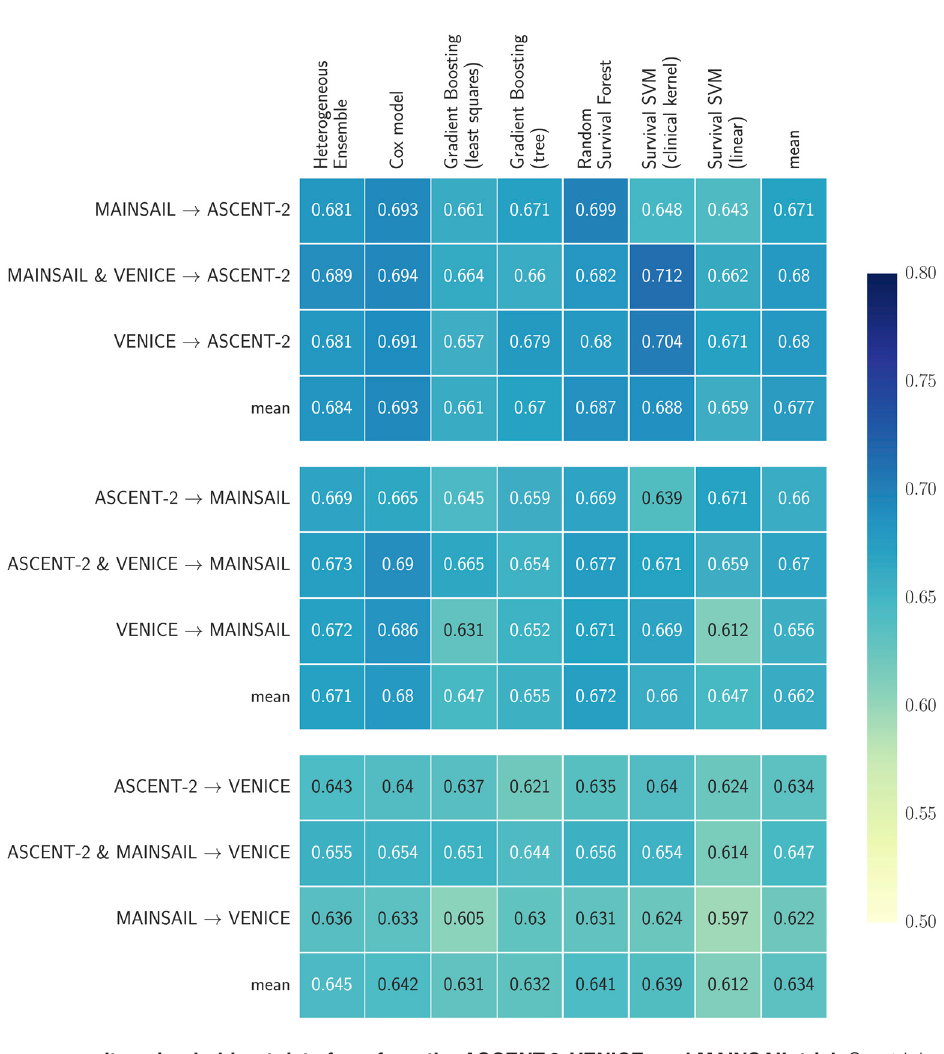
Figure 3. Performance results using hold-out data from from the ASCENT-2, VENICE, and MAINSAIL trial. One trial was used as hold- out data (indicated by the name to the right of the arrow) and one or two of the remaining trials as training data. Numbers indicate Harrell’s concordance index on the hold-out data.